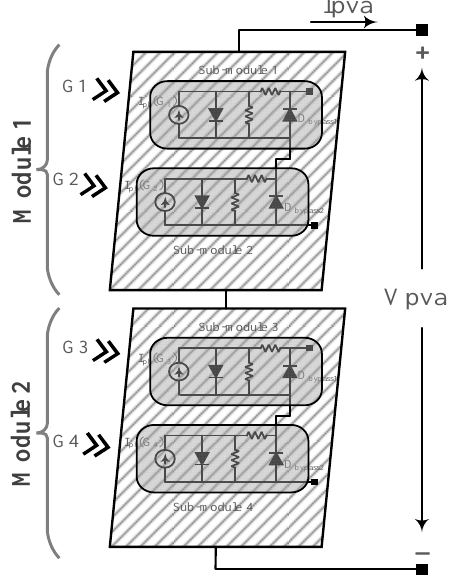
Figure 9. Circuitry diagram of the selected PV array [36].